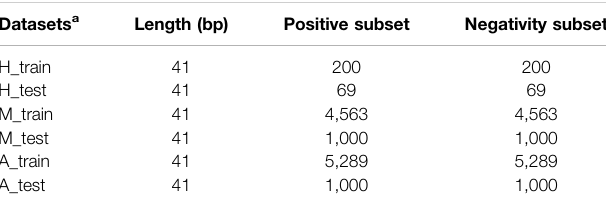
TABLE 1 | Training and test data sets of three